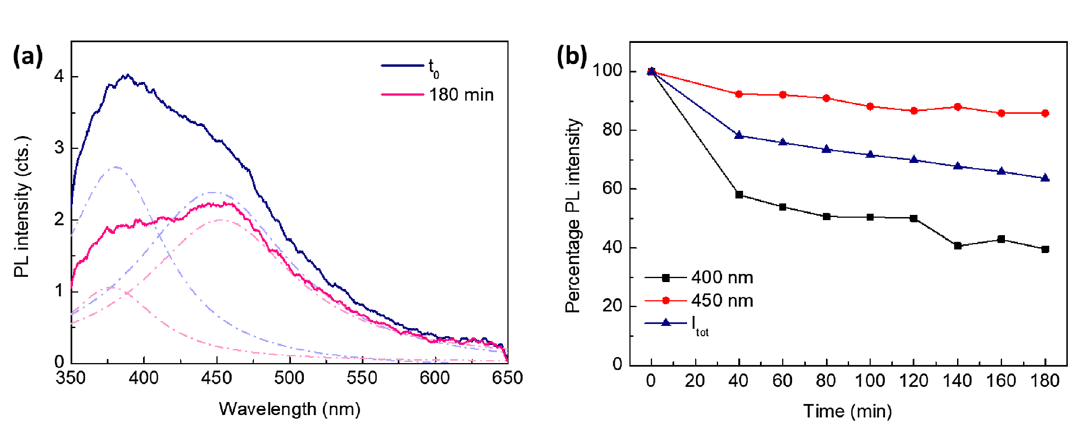
Figure 4. ( a ) PL spectrum of Ac-F6-Am (and its deconvolved components—dash-dotted lines) at t = 0 and after 180 min continuous exposure to 330 nm light. ( b ) Bleaching kinetic behavior of the 400 nm (black squares) and 450 nm PL components (red circles). The kinetics of the whole integrated signal as a function of the exposure time (blue triangles) is reported as